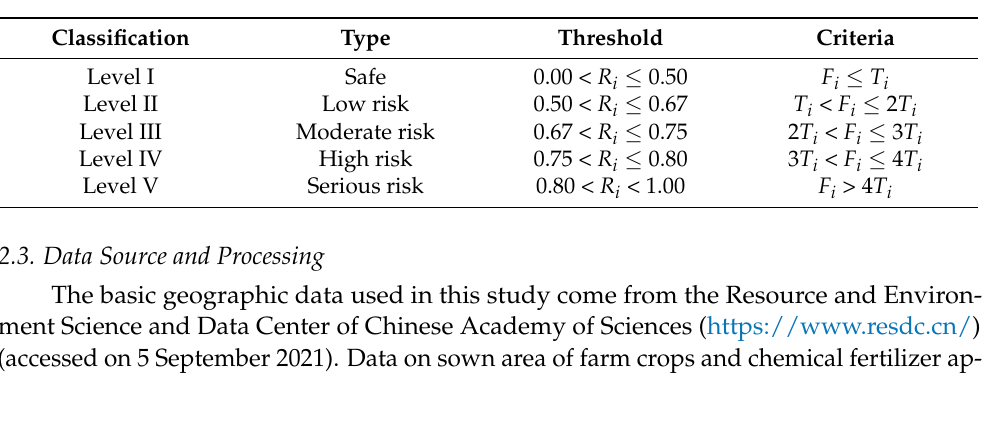
Table 1. Classification of the environmental risks of chemical fertilizer